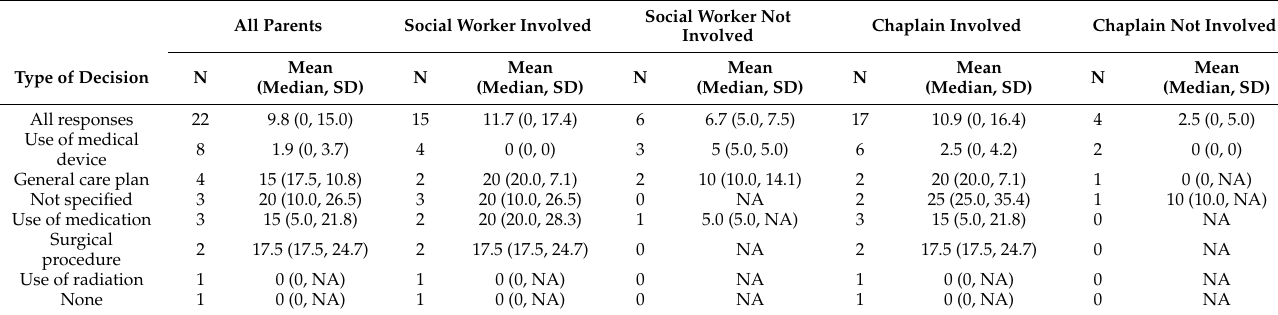
Table 4. Parent Decision Regret Scale (DRS)